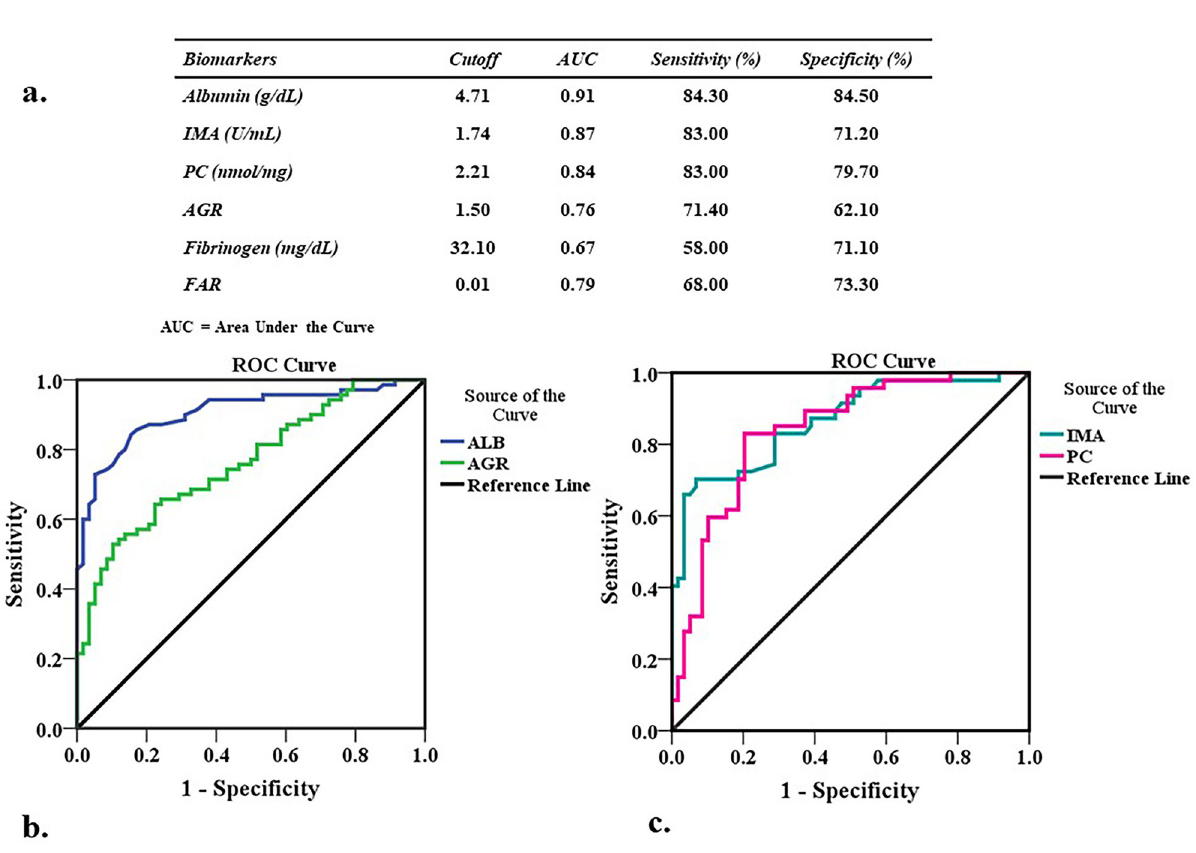
Fig 5. (a) The cutoff value, AUC, sensitivity and specificity of albumin, fibrinogen, AGR, FAR, IMA and protein carbonyl (PC) for distinguishing ACS from controls; (b) Receiver operating characteristic (ROC) curve of albumin (ALB) and AGR for distinguishing ACS from controls; (c) ROC curve of IMA and PC for distinguishing ACS from